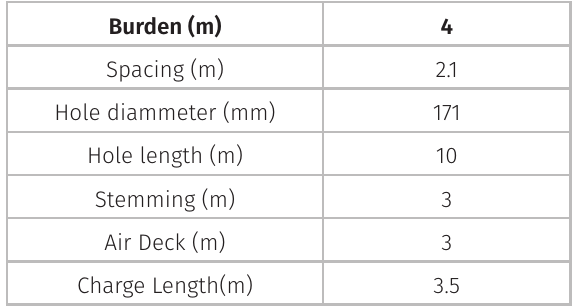
Table VI. Buffer design